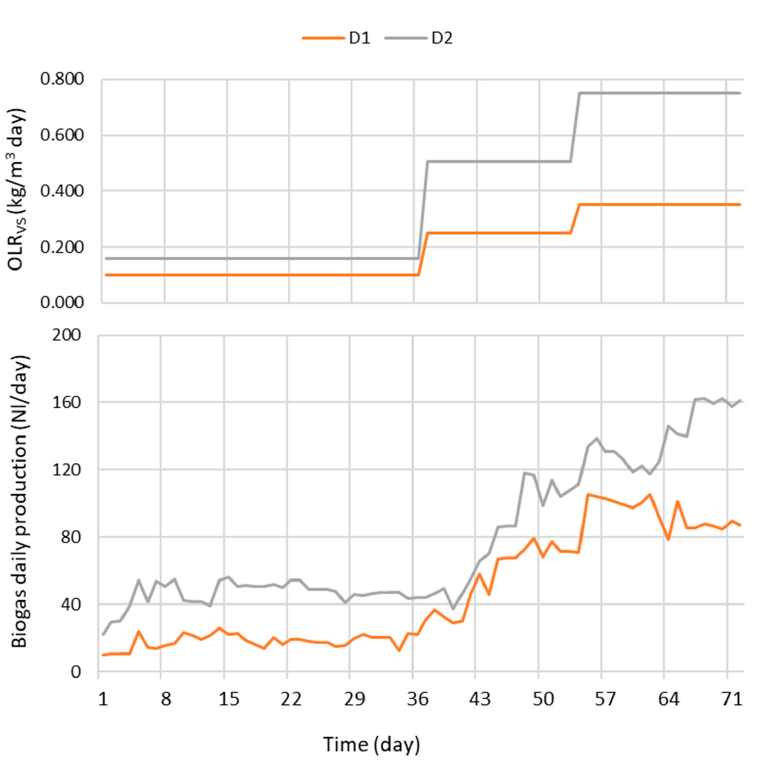
Figure 3. Evolution of OLR VS (above) and of daily biogas production (below).